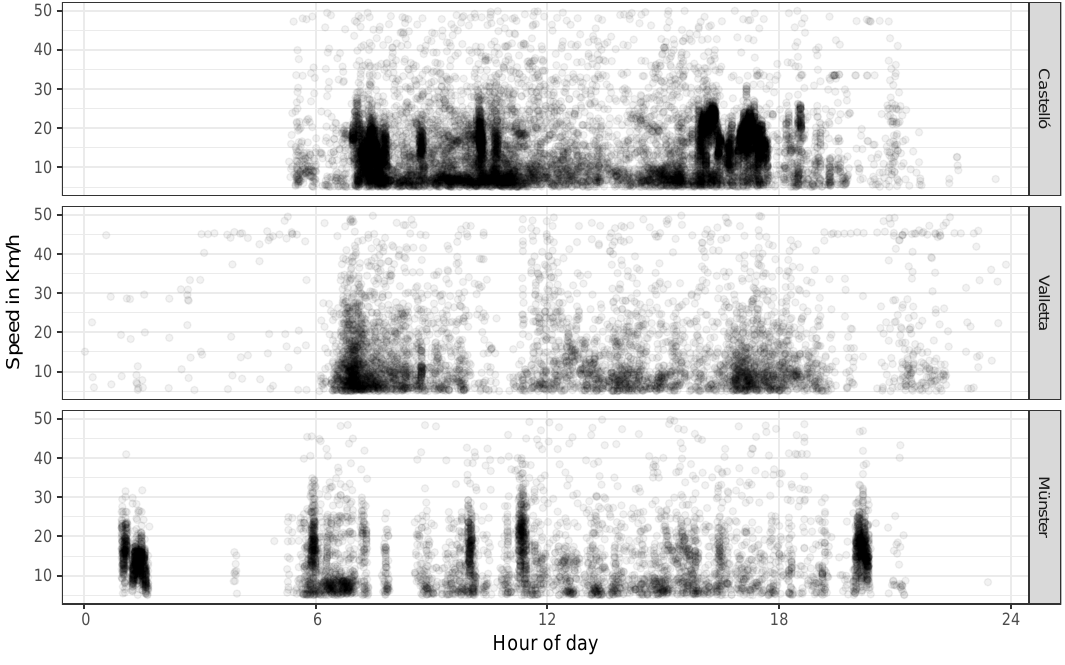
Figure 4. Cycling segments and speed distribution during the